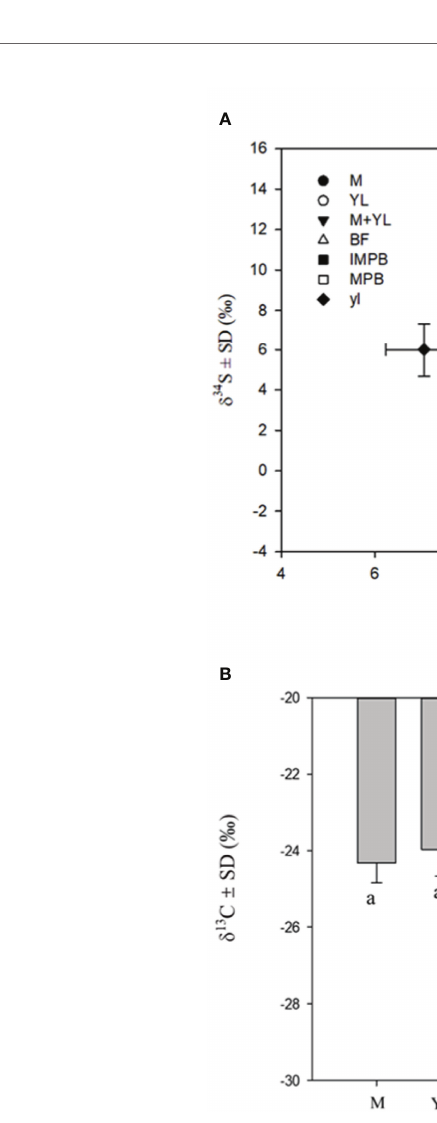
FIGURE 3 | Dual stable isotope plots (A) of mean d 15 N and d 34 S values and mean d 13 C (B) of crabs fed different food types and their food sources, different lowercase letters denote signi fi cant differences (p<0.05). M, crabs fed MPB; YL, crabs fed yellow leaves; M+YL, crabs fed MPB and yellow leaves; BF, before feeding; MPB, microphytobenthos; IMPB, incubated MPB with non labelled F/2 medium; yl, yellow